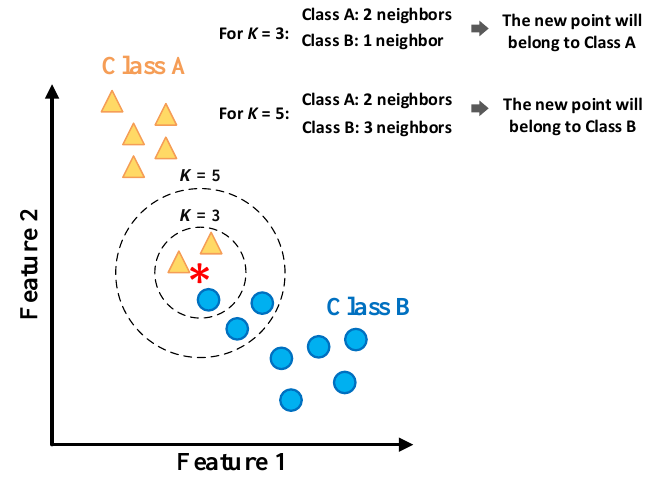
Figure 2. K-Nearest Neighbors classification principle.